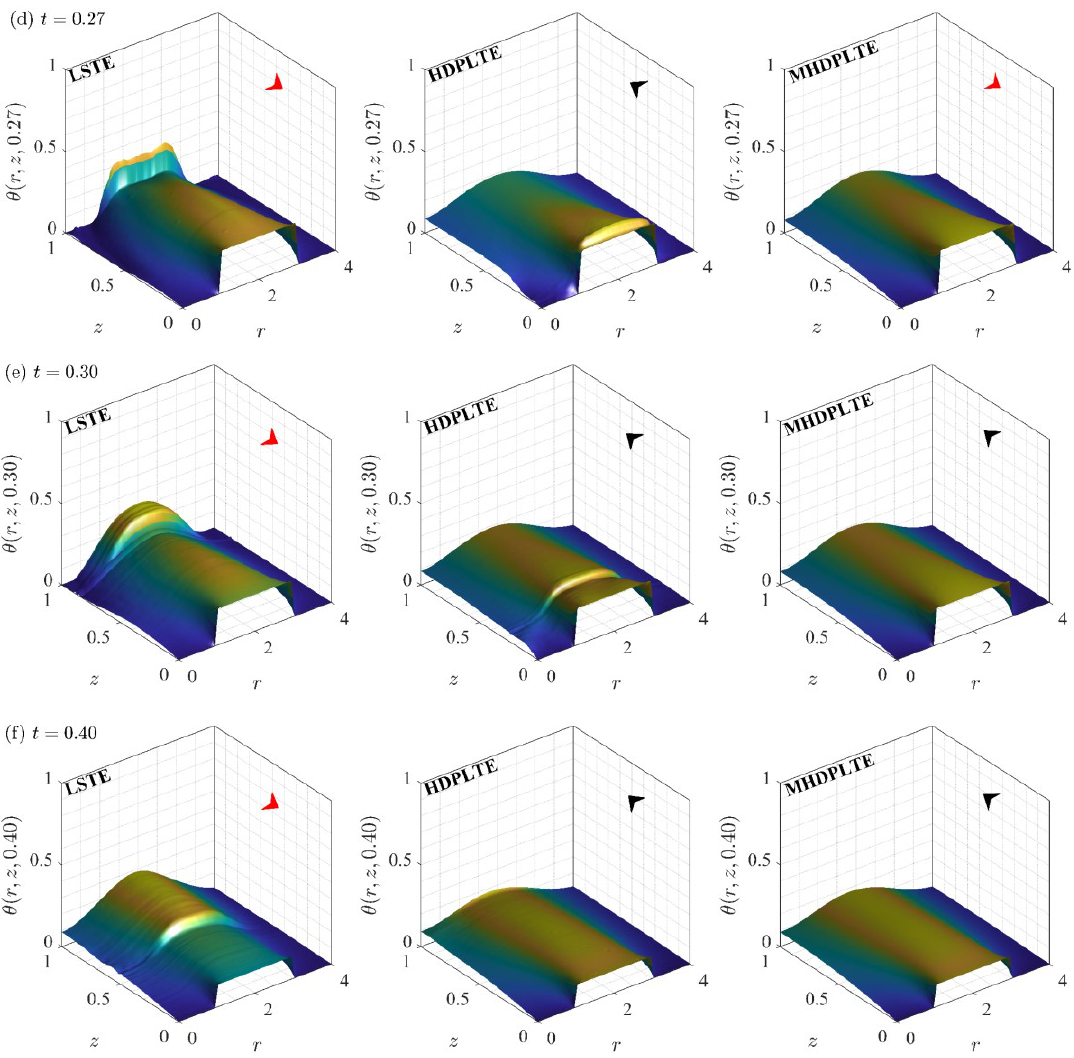
Figure 2. Temporal evolution of temperature on the space-time domain under the three theories of hyperbolic thermoelasticity, LSTE, HDPLTE and MHDPLTE: ( a ) temperature at t = 0.03, ( b ) t = 0.05, ( c ) t = 0.15, ( d ) t = 0.27, ( e ) t = 0.3, and ( f ) t = 0.4.